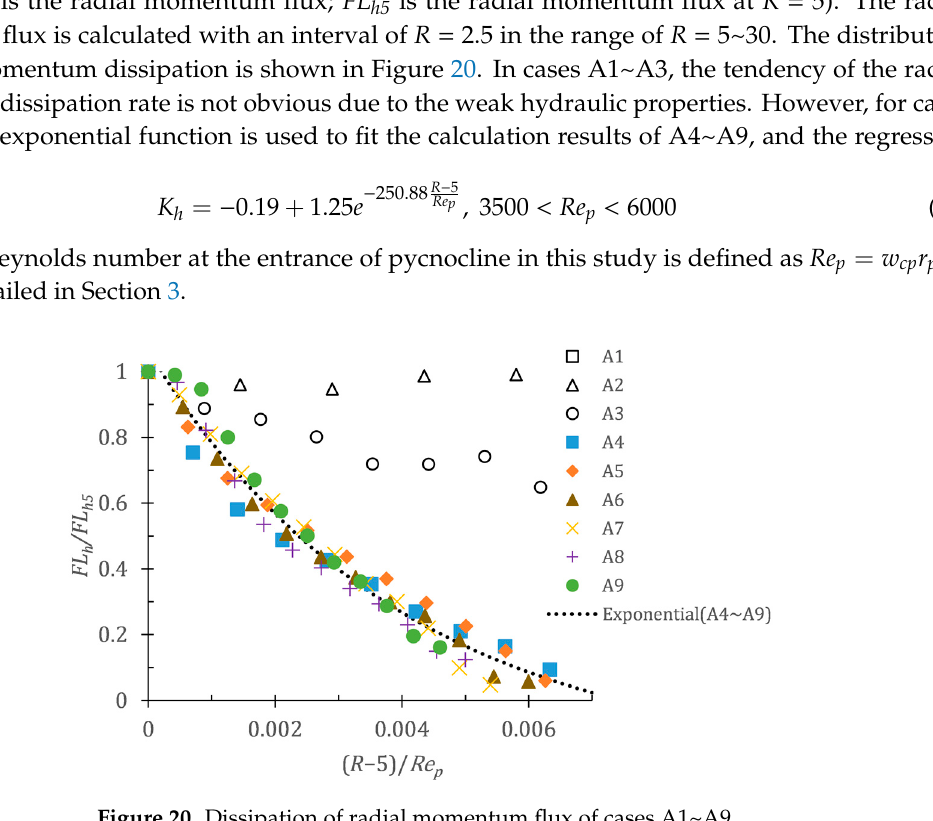
Figure 19. Momentum flux dissipation rate of jets vs Fr p.